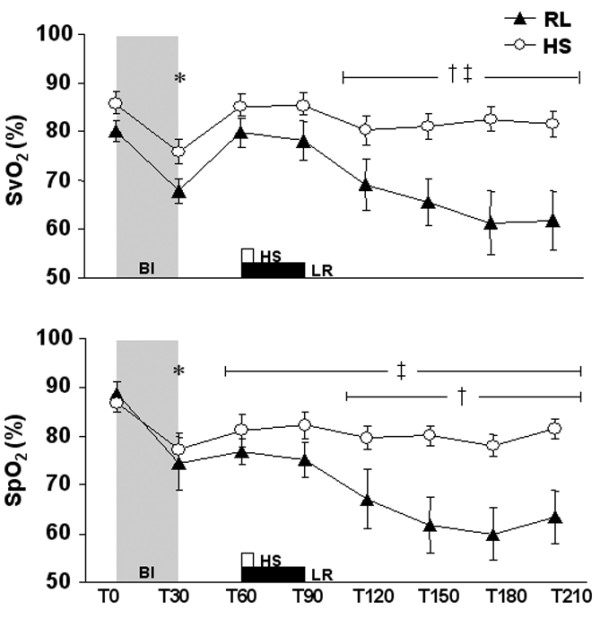
Mixed venous (SvO2) and portal (SpO2) oxygen saturation (%, mean ± standard error of the mean) during the experimental protocol. LR group received lactated Ringer's solution 32 ml/kg over 30 minutes, n = 7; HS group received 7.5% hypertonic saline solution 4 ml/kg over 5 minutes, n = 8. *p < 0.05 versus T0, both groups; †p < 0.05 versus HS; ‡LR, p < 0.05 versus T0. BI, bacterial infusion.